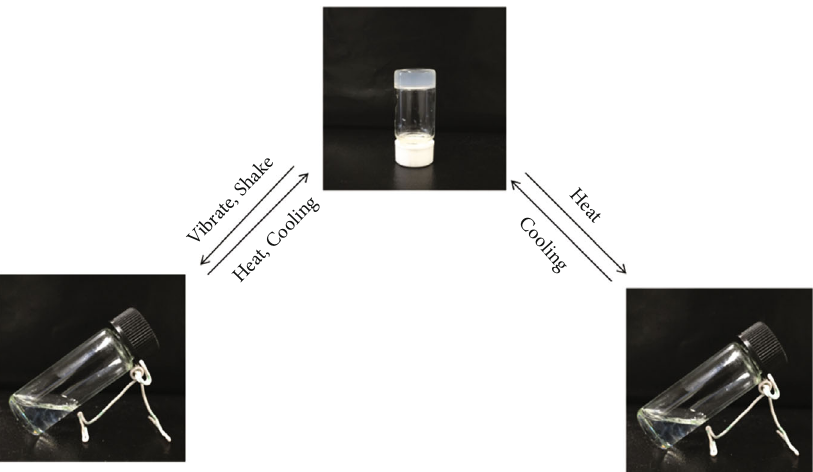
Figure 5: Gel-sol transition diagram of DMTCP (CCl